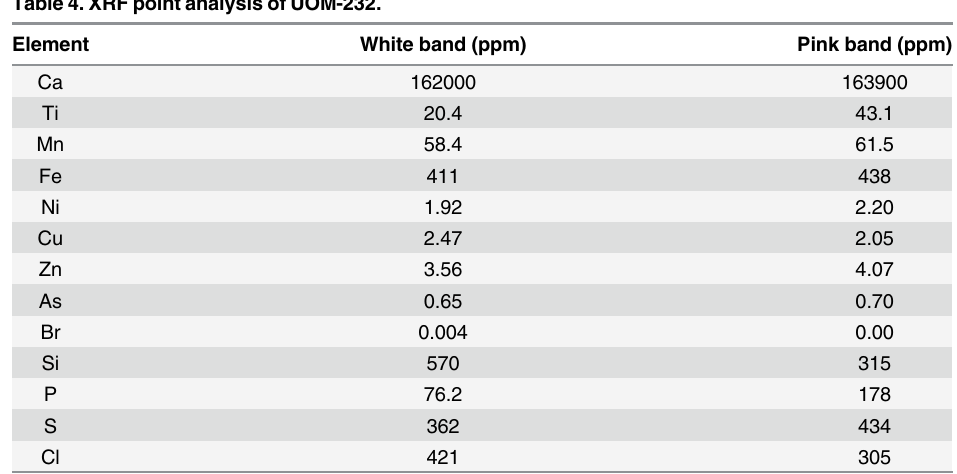
Table 4. XRF point analysis of